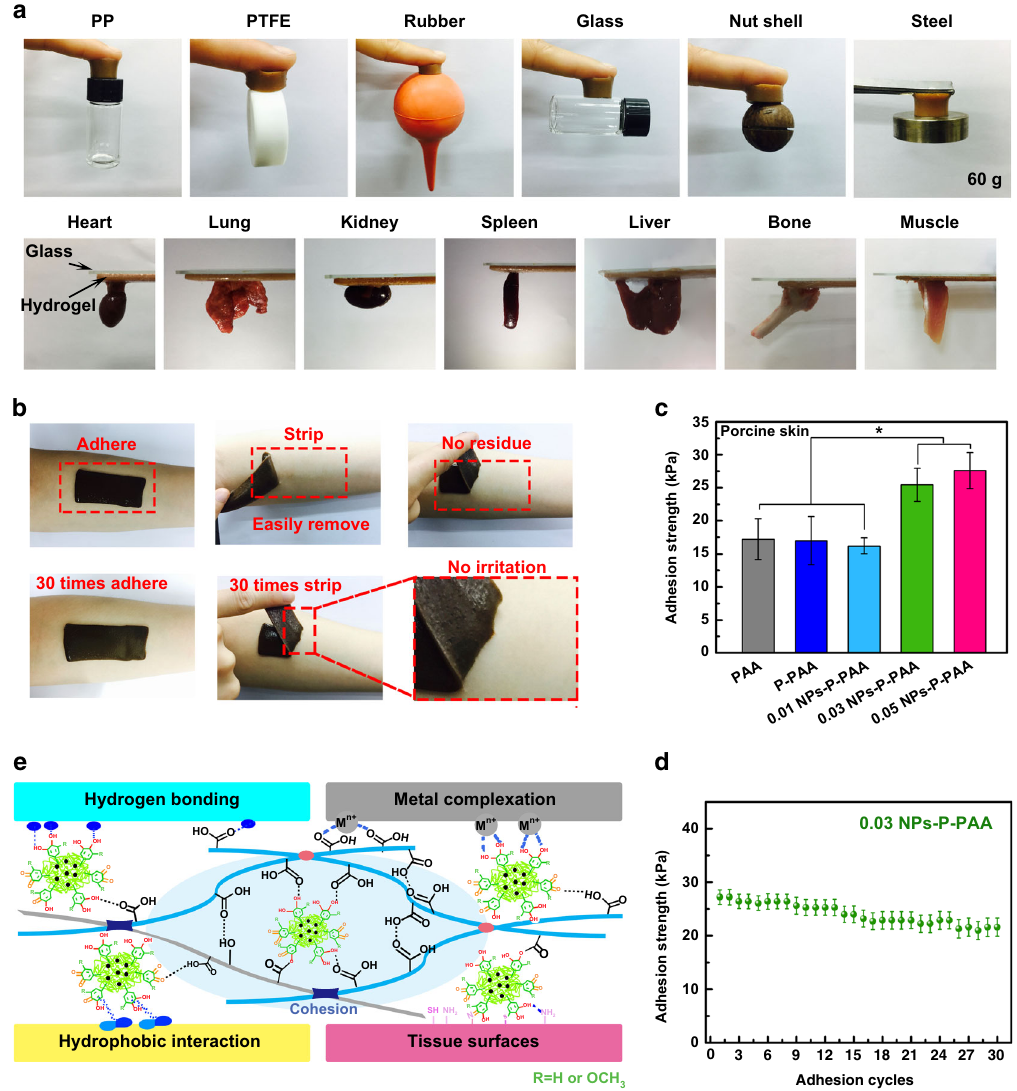
Fig. 3 Adhesive properties of the NPs-P-PAA hydrogel. a The hydrogel was adhered to various material surfaces and tissues. b The hydrogel was repeatedly adhered on the skin of the author. After peeling off, no residue or irritation on skin was found. c The adhesive strength of various hydrogels to porcine skin. d The repeated adhesion of 0.03 NPs-P-PAA hydrogels to porcine skin after 30 cycles of adhering – stripping. e The adhesion mechanism of the NPs-P-PAA hydrogel. The blue oval indicated the hydrogen bonding or hydrophobic interaction between the hydrogel and different surfaces. (Error bar means the standard deviation, * indicates statistically difference at p < 0.05, p value was generated by one ‐ way analysis of variance (ANOVA), followed